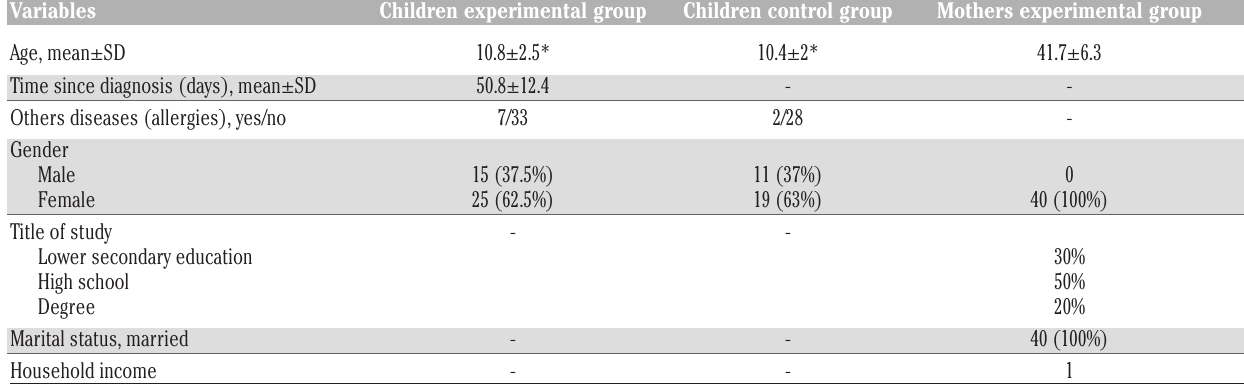
Table 1. Characteristics of experimental group (40 children and their mothers) and control group (30 children).